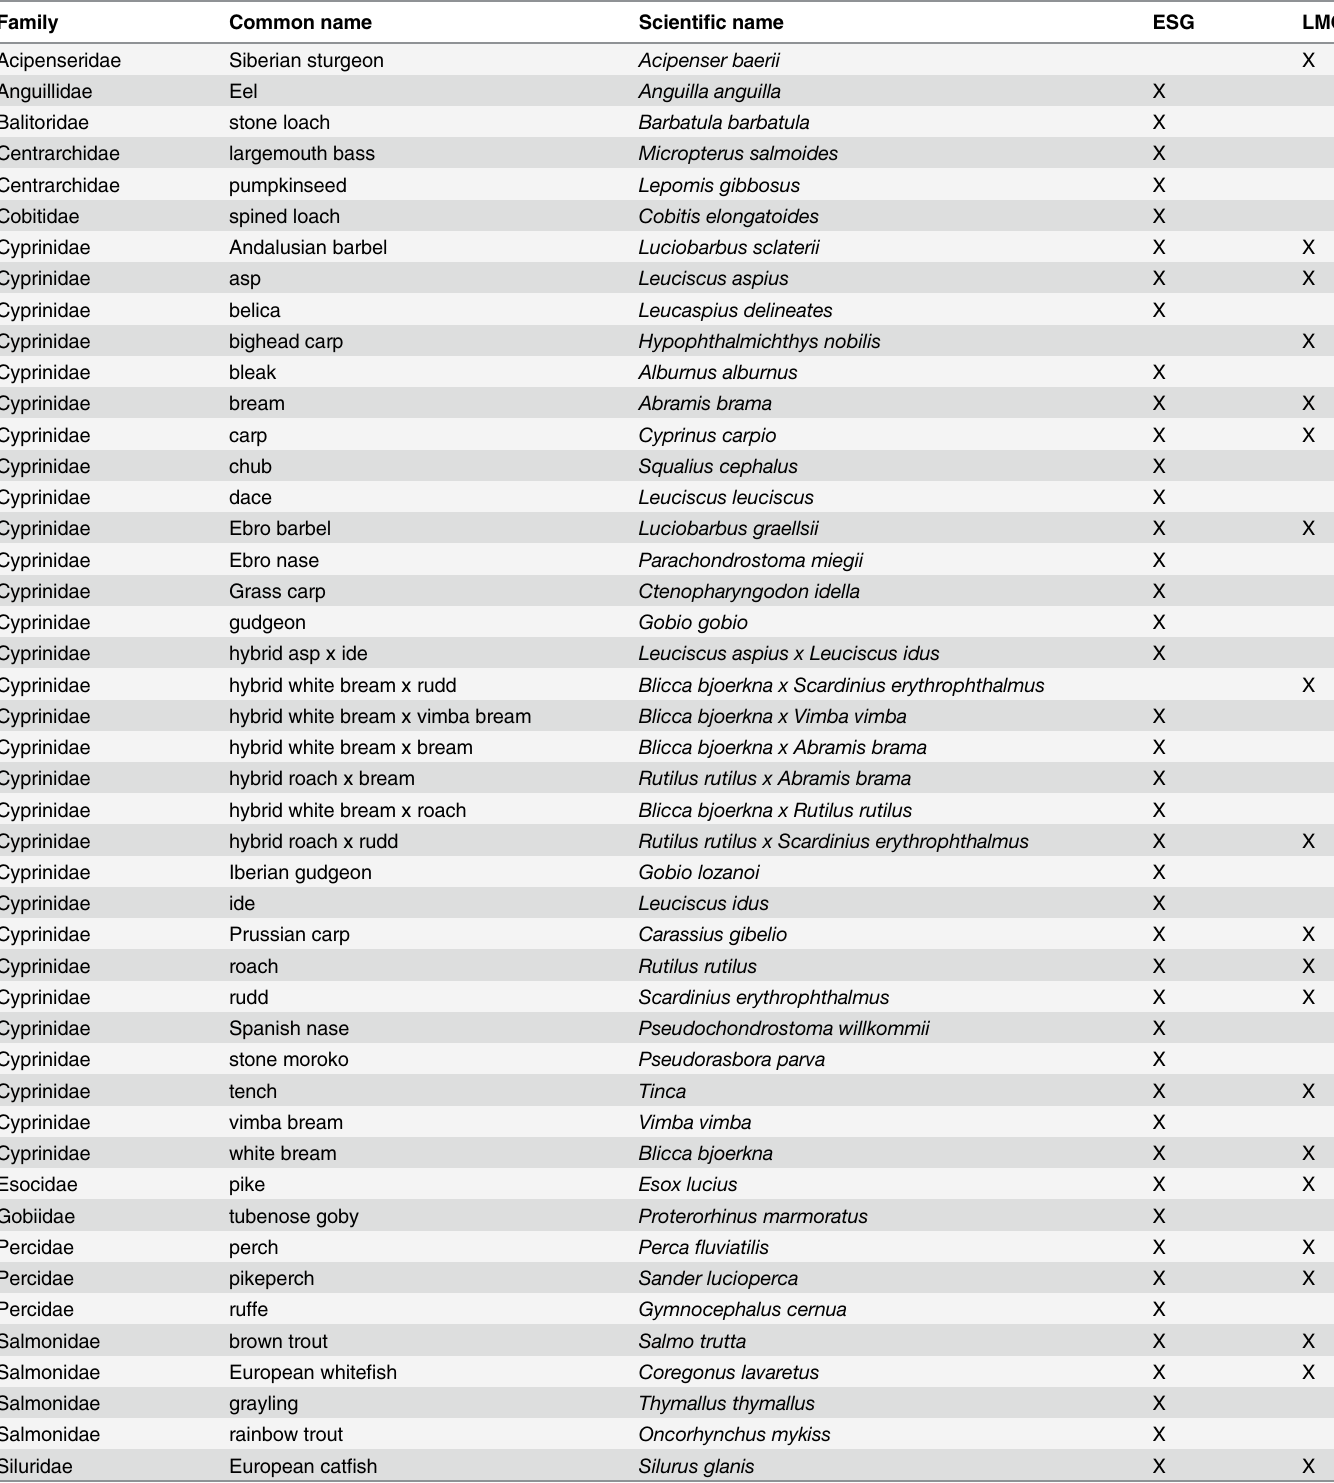
Table 1. Species captured by ESG and LMG in all water bodies sampled during the study.